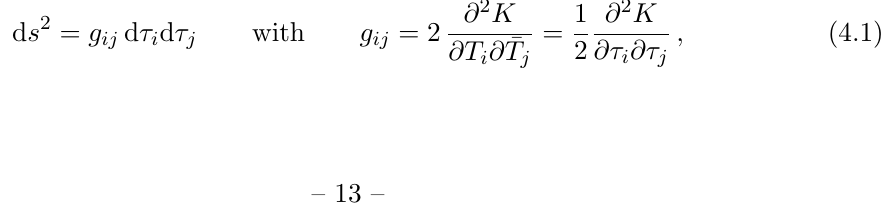
= 10 3 , 10 4 and 10 5 0